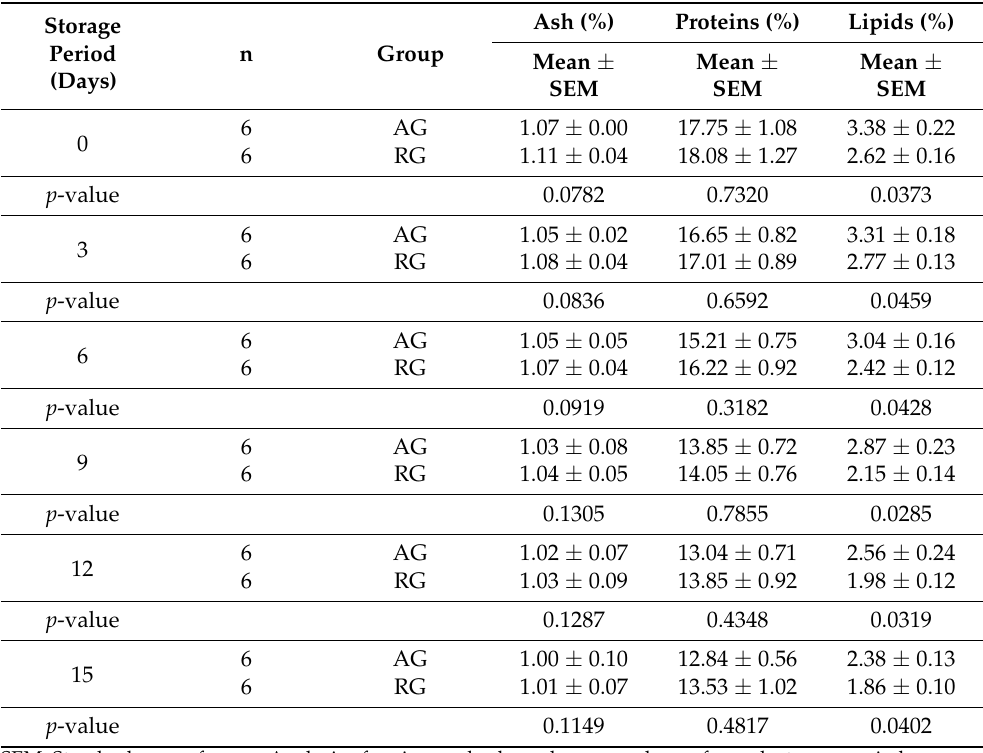
Table 5. Evaluation of dry matter constituents from European catfish flesh in different storage